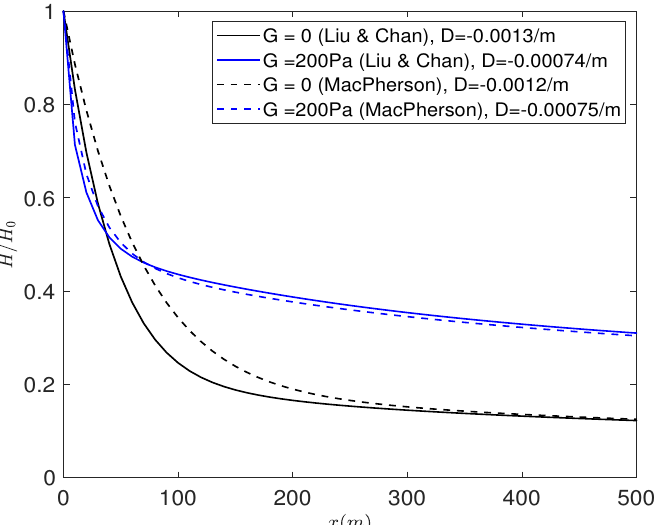
Figure 17. Spatial variation of random wave H rms over viscous ( G = 0) and viscoelastic mud with shear modulus of G = 200 Pa, as normalized by incident wave height H 0 , ζ = 100, h = 0.80 m, d m = 0.40 m, and ρ m = 1111 kg/m 3